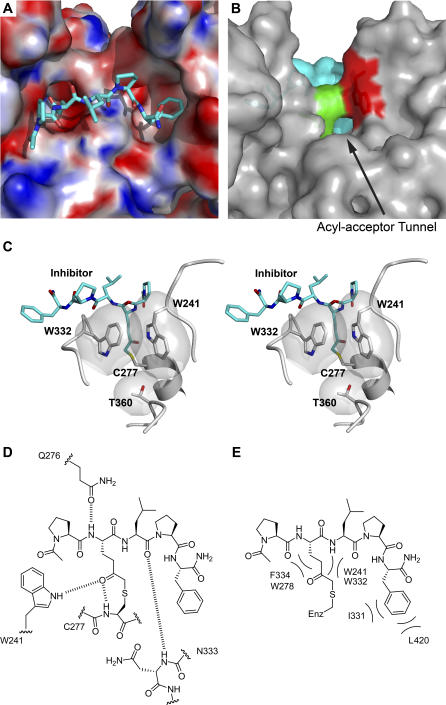
The Active Site of TG2 and Enzyme–Inhibitor Interactions(A) Electrostatic potential surface of TG2 (red indicates negative charge; blue, positive; contoured at −15 kBT to +15 kBT) in the vicinity of the peptide inhibitor. (Carbon is indicated by cyan; nitrogen by blue; and oxygen by red.)(B) Surface representation of the active-site tryptophan bridge. W332, W241, and inhibitor are shown in green, red, and cyan, respectively. The proposed acyl-acceptor approach site is indicated.(C) Stereo representation of the active site of TG2. The backbone of TG2 is shown as ribbons. The bridge tryptophans and a T360 that resides in front of the proposed acyl-acceptor entrance are shown as sticks with semitransparent surfaces. It can be seen that the bridging tryptophan residues reside on separate loops above the catalytic Cys (sulfur is indicated by yellow). The thioether attachment of the inhibitor (cyan indicates inhibitor carbons, and gray indicates TG2 carbons) is also evident.(D) Hydrogen-bonding interactions between TG2 and the peptide are shown as dashed lines.(E) Schematic diagram of hydrophobic interactions between TG2 and the inhibitor.